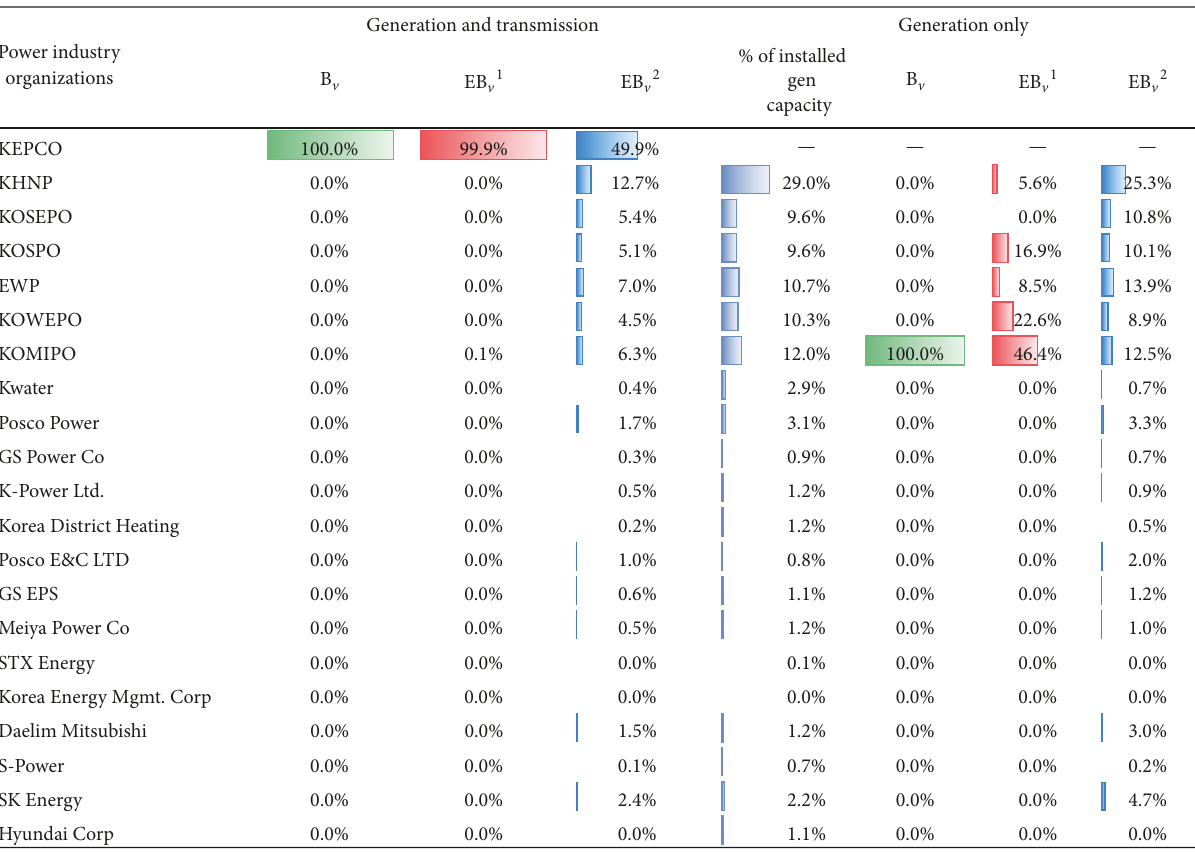
Figure 2: Criticality of KPG buses aggregated by power industry